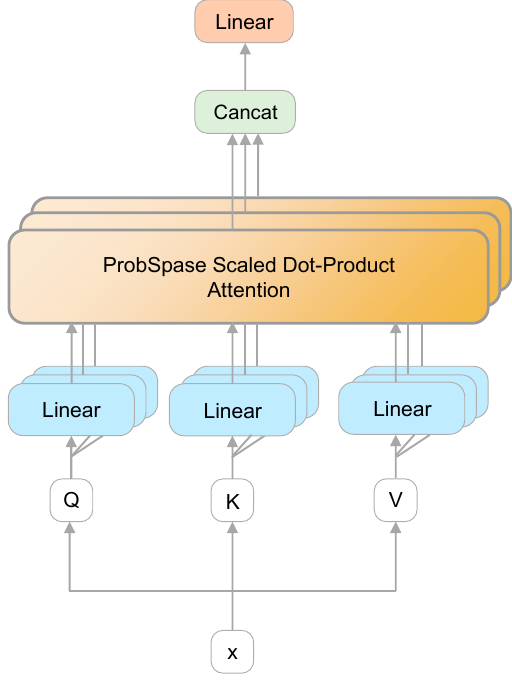
Figure 4. Illustration of the multi-head attention layer.